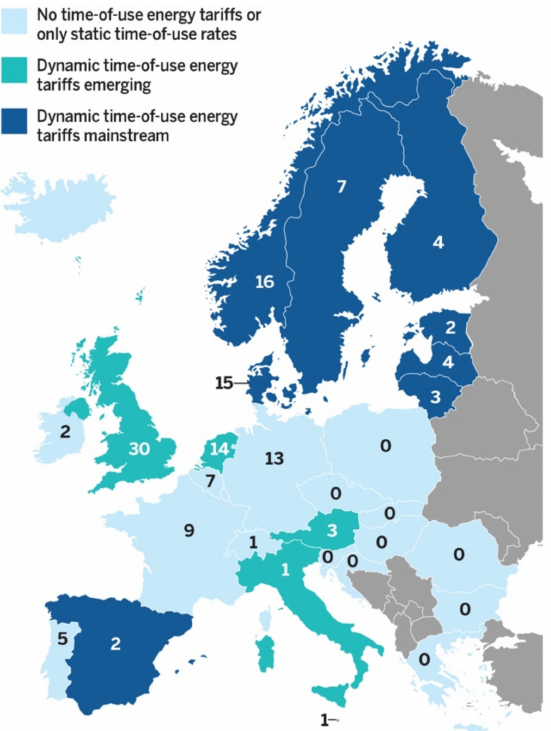
Figure 2. Number and distribution of smart charging tariffs and services across Europe. Source: own research, see Appendix A for